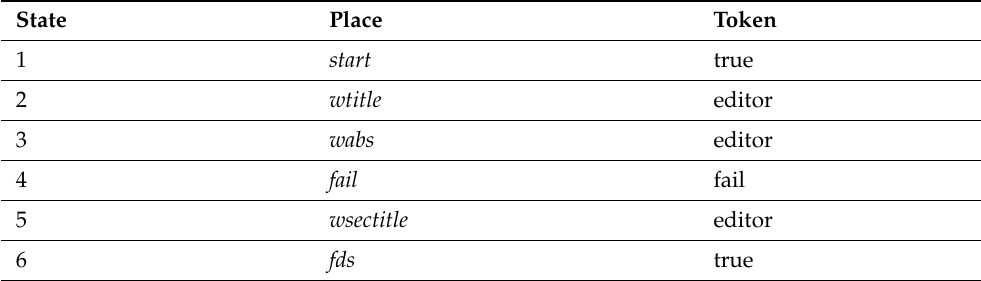
Table 4. State space markings of Writing Paper